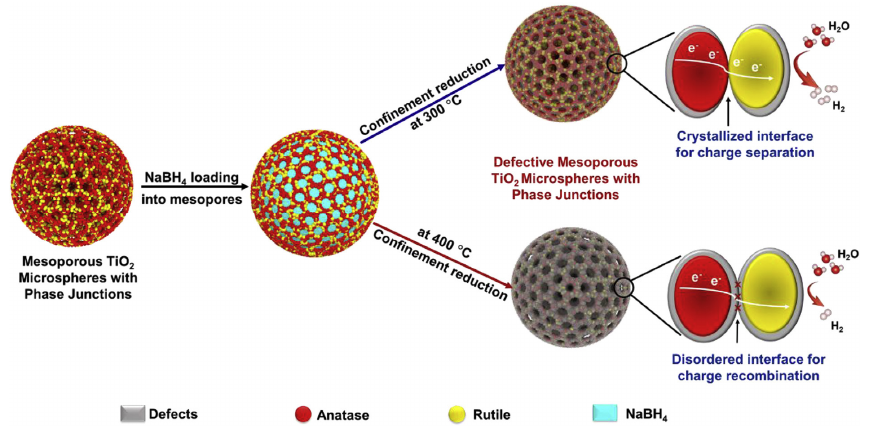
Figure 15. Schematic illustration of the synthesis of defective mesoporous titania microspheres with phase junctions via a facile confinement reduction method. Copyrights 2019 Elsevier [140].